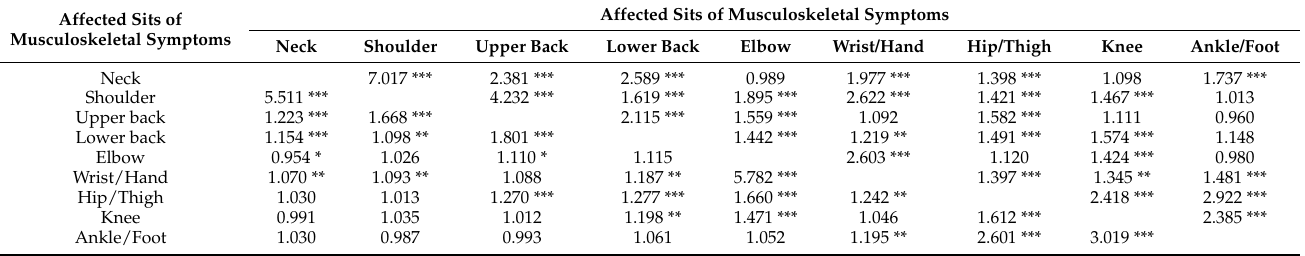
Table 4. The results indicate that “neck and shoulder” were major sites of concurrent mus- culoskeletal symptoms in two body sites, and the number of positive cases (positive rate) was 246 (3.4%), accounting for 38.2% of the total number of positive cases. Musculoskeletal symptoms in the “neck and lower back”, “shoulder and upper back”, and “neck and